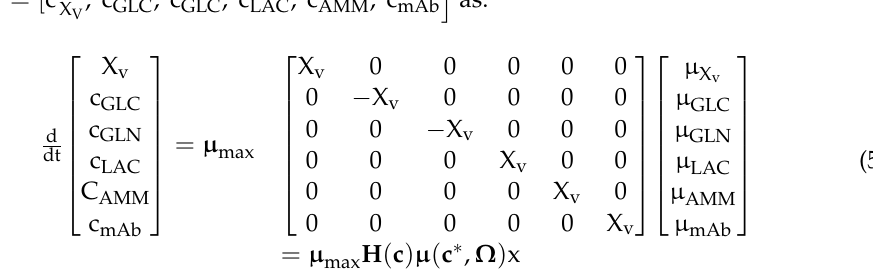
Figure 3. Structure of the hybrid digital model to generate in silico batches.